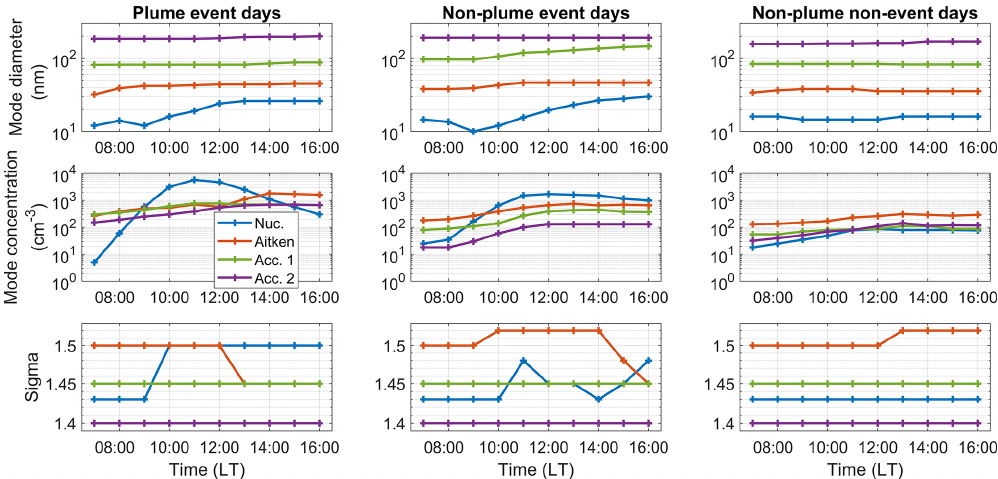
Figure 7. Variations of the parameters of the Gaussian modes used to fit the hourly median DMPS size distributions shown in Fig. 6. All the displayed values are also reported in Table A1 of Appendix